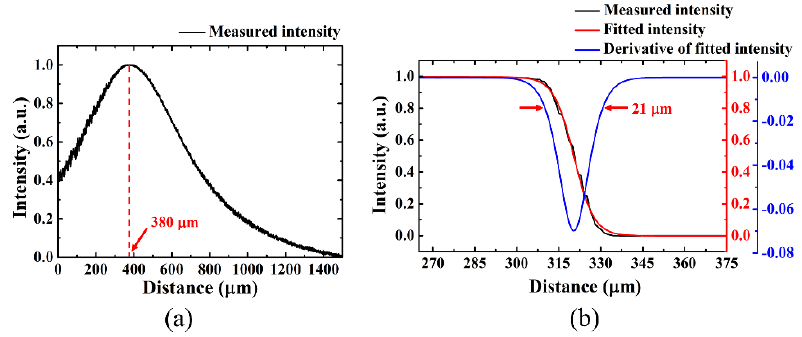
Figure 3. Performance evaluation of a fabricated LOF. ( a ) Back-coupled beam intensity measured as a function of the axial distance of a sharp-edge mirror. ( b ) Back-coupled beam intensity measured as a function of the lateral displacement of the sharp-edge mirror, located at the working distance of the LOF.